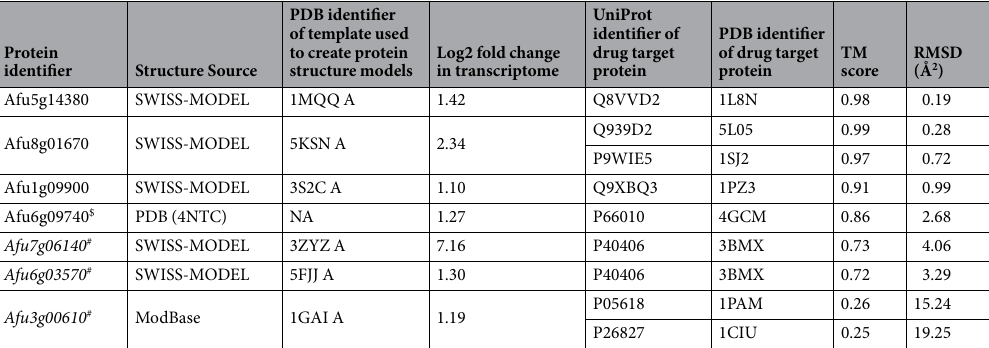
Table 1. Evaluation of the structural similarity of secreted and cell membrane proteins upregulated in the transcriptome of Aspergillus fumigatus Af293 with their close sequence homologs among known drug target proteins in DrugBank 25 . Note that the last three A. fumigatus proteins italicized in this table are not structurally similar to their close sequence homologs among known drug target proteins. $ An experimentally solved crystal structure was available from PDB for this protein. # These three A. fumigatus proteins are not structurally similar to their close sequence homologs among known drug target